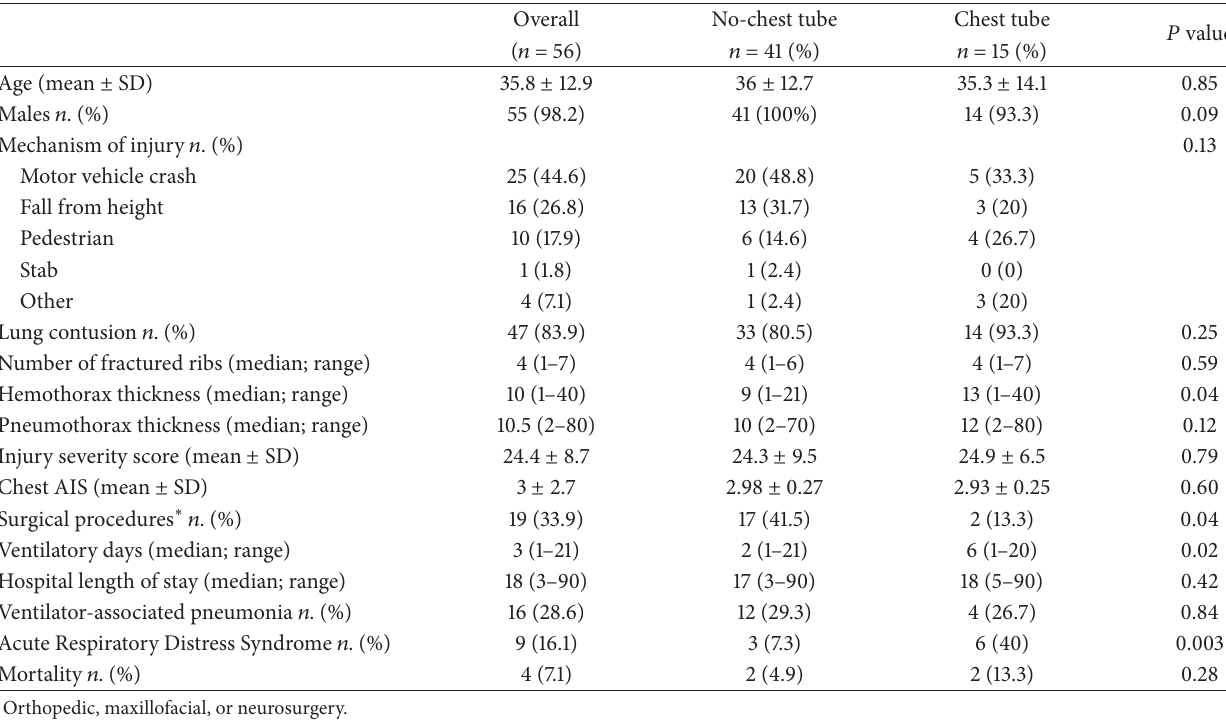
Table 1: Comparison of patients with chest tube versus no-chest tube.